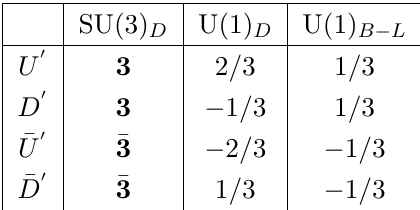
Table 1 . The charge assignment of the dark quarks in the vector-like QED model in ref. [32]. Both the dark quarks and the dark anti-quarks are given as the left-handed two-component Weyl fermions.